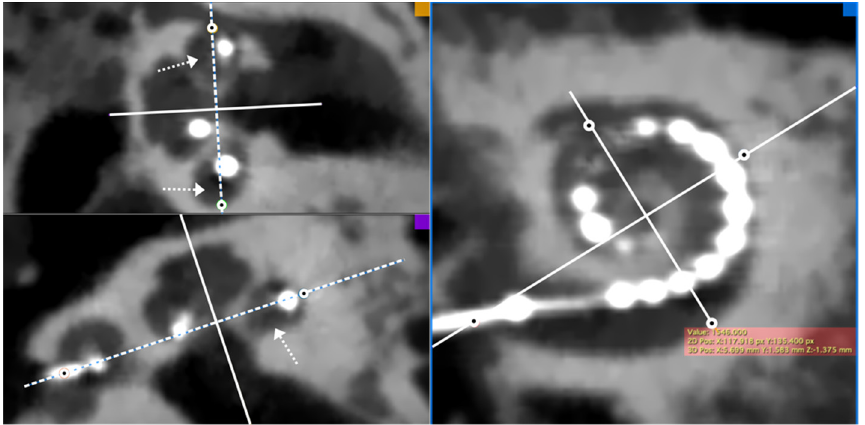
Figure 2. Determination of the 3D positions of four landmarks (the center of the round window, and the lateral wall at 90 ◦ , 180 ◦ , and 270 ◦ ) on a post-implantation CBCT image. Note that the coronal plane (dashed line) is aligned with the middle of the cochlear turn regardless of the position of the electrode (white arrows). The point corresponding to the intersection between the middle cochlear turn line and the lateral wall was selected.